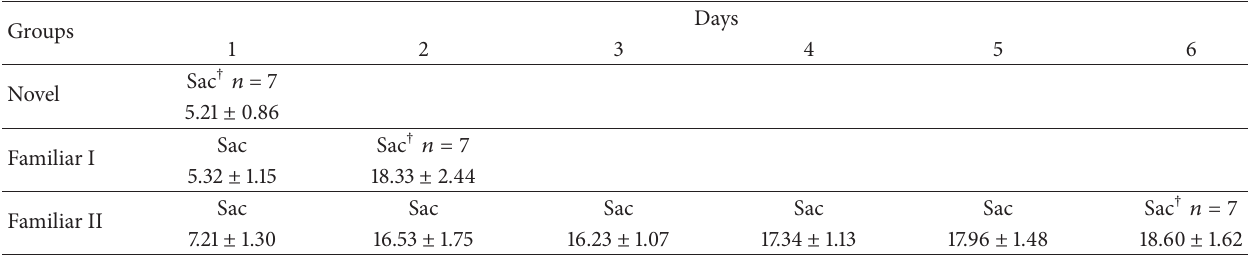
Table 1: Timeline depicting the experimental procedure. Mean ( ± SEM) intake during the six saccharin solution (Sac) exposure sessions ( 𝑛 = number of animals per group; Sac = 0.4% saccharin solution; † sacrifice 30min after the drinking period).